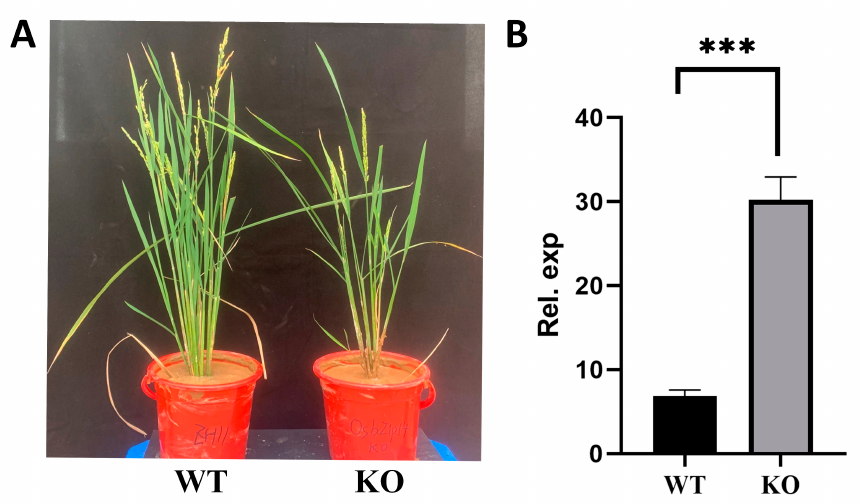
Figure 10. OsbZIP14 gene knockout and its WT plants under heat stress. ( A ) Overall phenotypic comparison of WT and OsbZIP14 KO rice plants under 5d heat stress. ( B ) Analysis of OsbZIP58 expression levels in WT and mutant rice plants under 5d heat stress. The statistical significance of the expression changes was determined using the student t -test, ‘***’ indicating a p -value < 0.001.